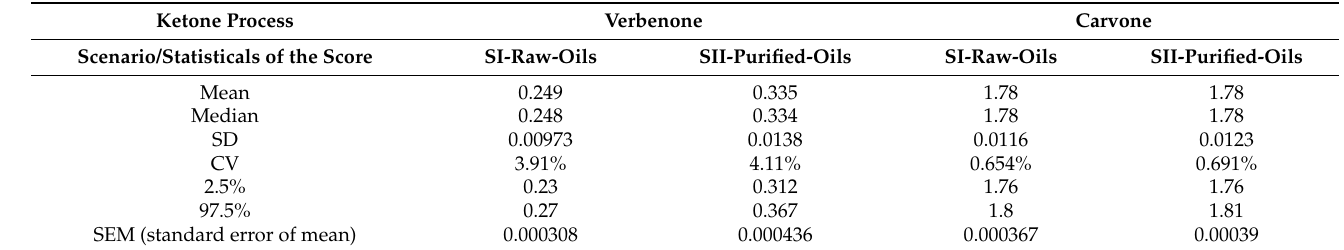
Table 3. Statistical parameters (by score) of the uncertainty analysis of the processes. Assessment methods: ReCiPe 2016 Endpoint (H) V1.06/World (2010) H/A; number of bins: 50, visible interval: 99.9%, confidence interval: 95%. Functional unit: 1 kg of ketone/batch.